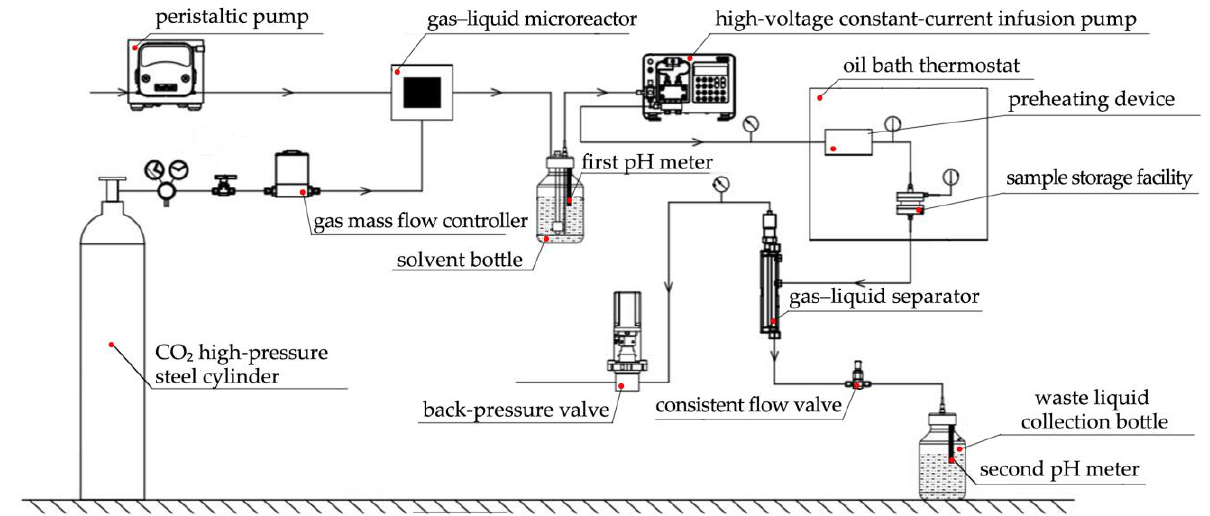
Figure 4. Flow chart of the dissolution test [7].